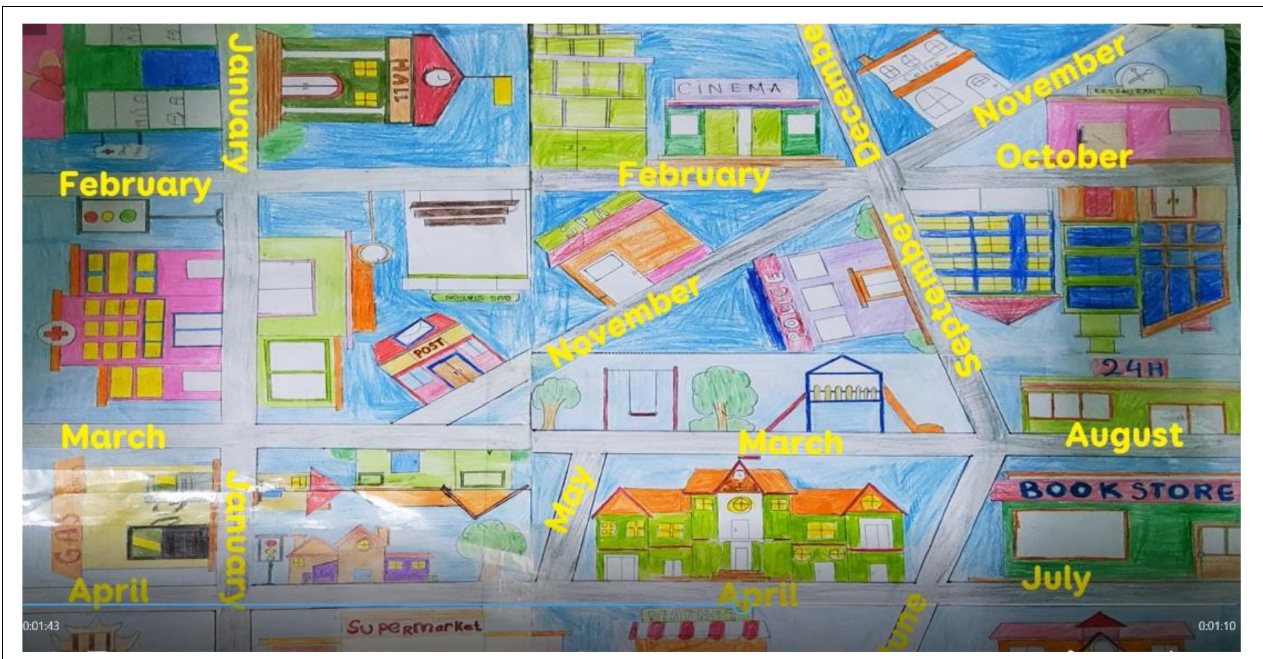
FIGURE 2 | Product of student